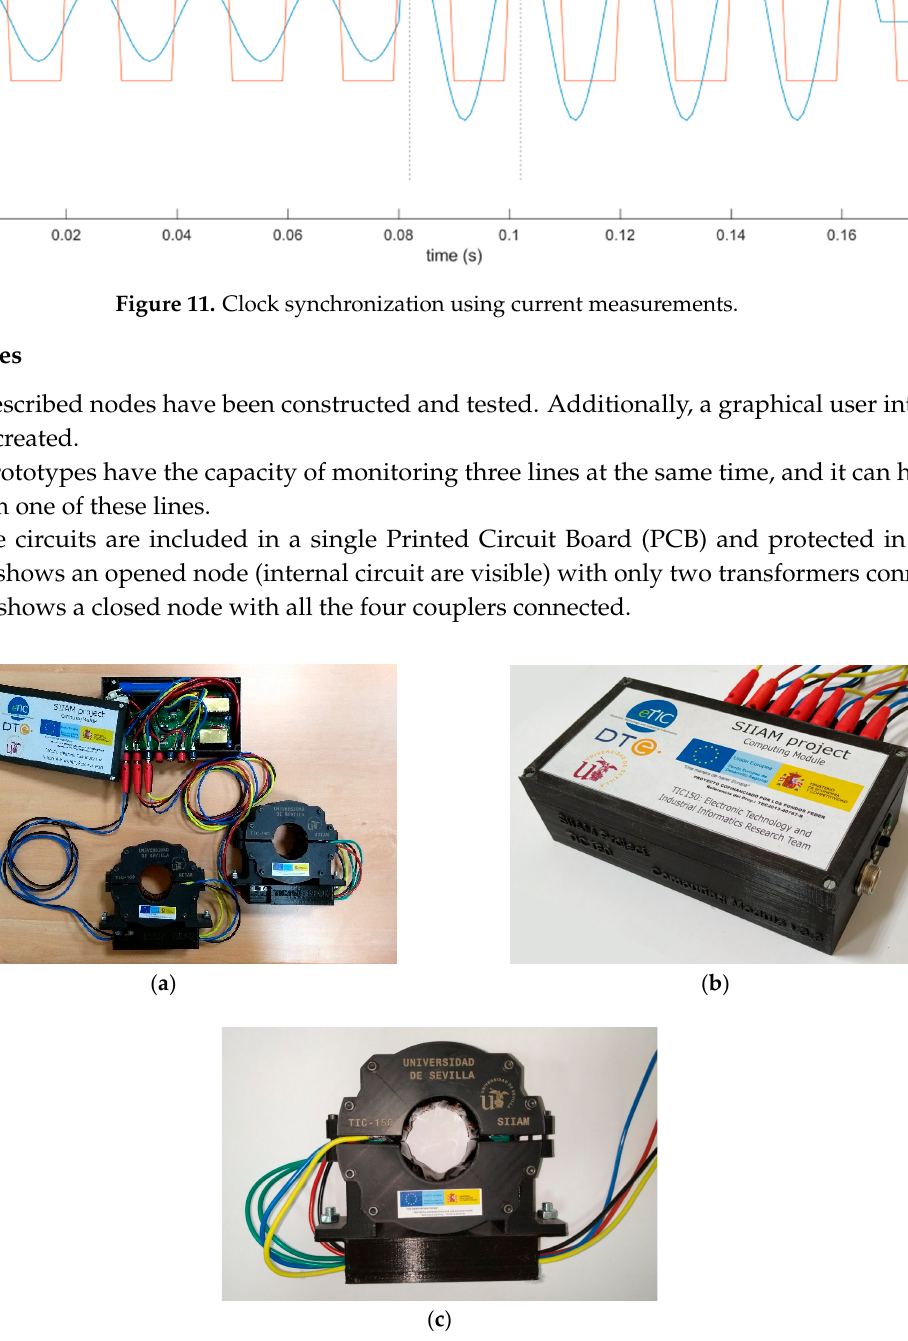
Table 2 . Prototype